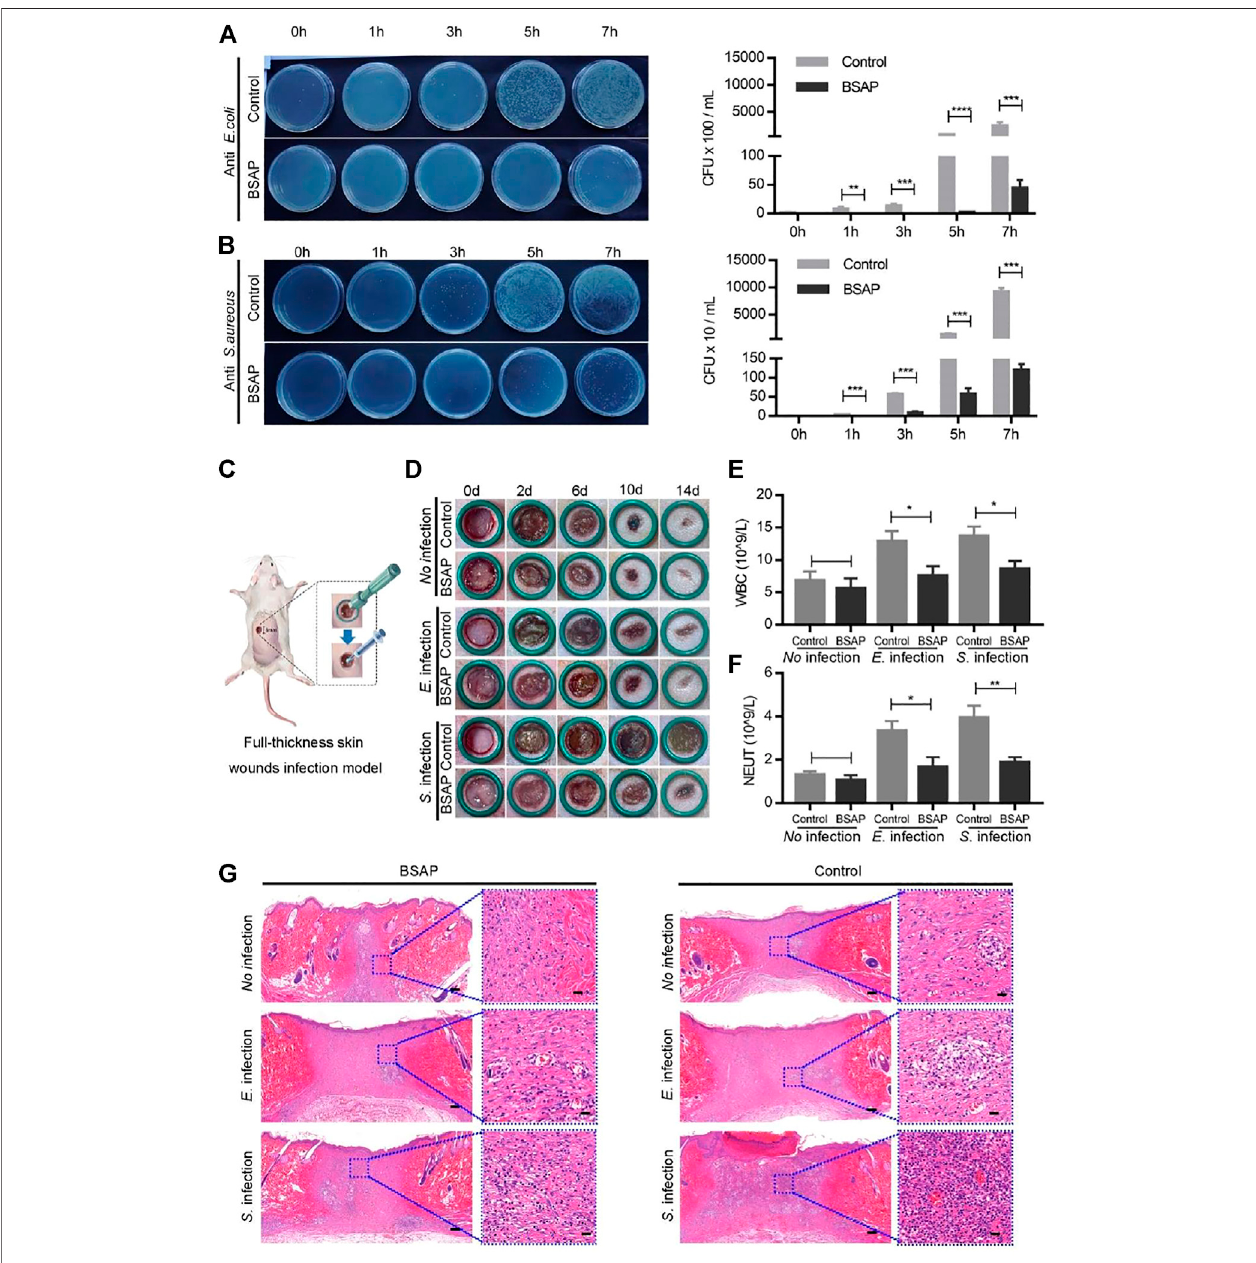
FIGURE 4 | Antibacterial property of BSAP hydrogel. (A) . The effects of BSAP hydrogel on E. coli adhesion to HUVEC cells during bacterial infection. Colony counting ofbacterialadheringonthecellmembranes(1/1,000dilution).( n =3, p P < 0.05, pp p < 0.01, ppp p < 0.001, pppp p < 0.001 ). (B) TheeffectsofBSAPhydrogelon S. aureus adhesion to HUVEC cells during bacterial infection. Colony counting of S. aureus adhering on the cell membranes (1/100 dilution). ( n = 3, p P < 0.05, pp p < 0.01, ppp p < 0.001, pppp p < 0.001 ) (C) Schematicillustrationoftheestablishmentoffull-thicknessskinwoundsinfectionmodel. (D) Representativewoundphotosinfected woundstreated withBSAPhydrogel. (E, F) White blood cell(WBC)count (E) and Neutrophil (NEUT) count (F) ofthe full-thicknessskin wounds infection model onday 1 after modeling treatment (n = 3, p P < 0.05, pp p < 0.01, ppp p < 0.001, pppp p < 0.001 ). (G) H and E-stained skin histological sections of wounds healing (scale bar: 200 nm) and in fl ammation (scale bar: 20 μ m) on day 14 after modeling